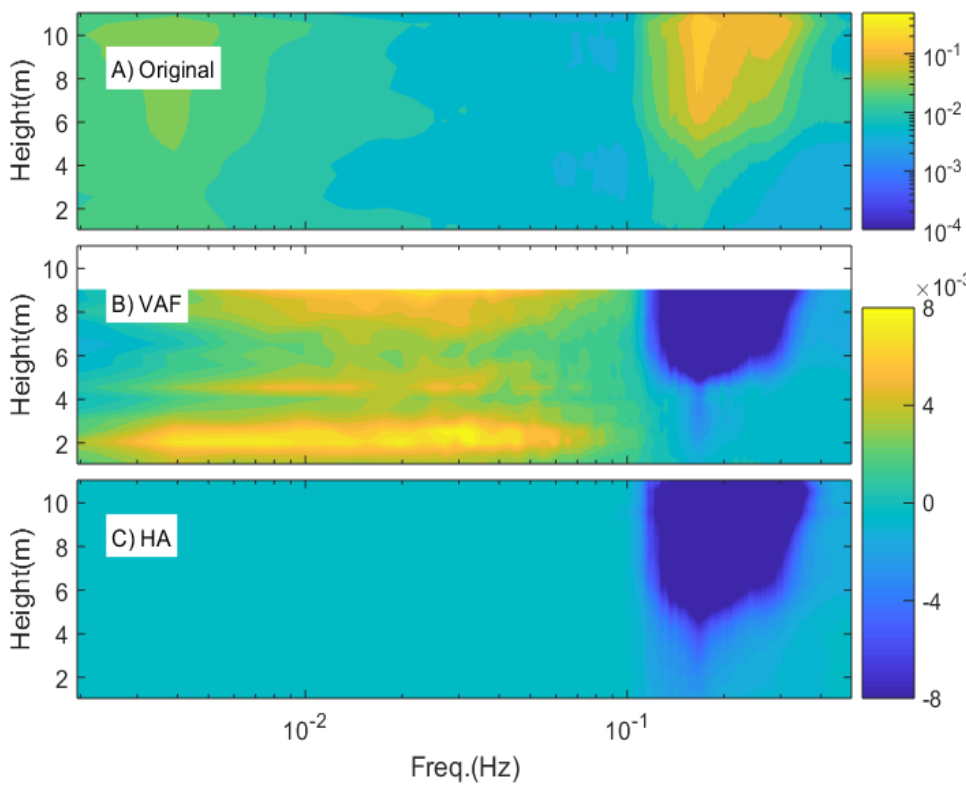
Figure 5. ( A ) Time-averaged PSD (m 2 /s) as a function of height above bottom with original Beam1 velocities. ( B ) Difference between the VAF method and the original time-averaged PSD. ( C ) Difference between the HA method and original time-averaged PSD.